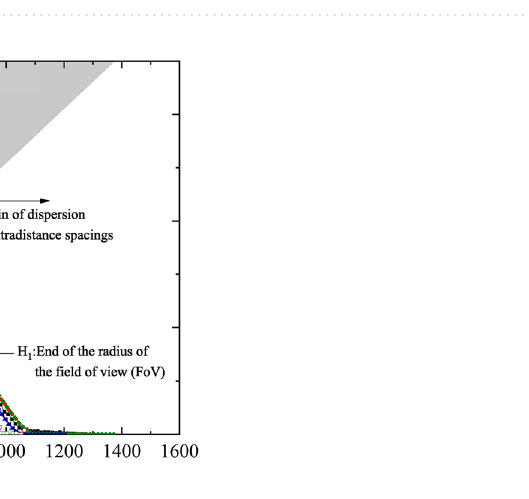
Figure 11. Plot of the radial distribution function H 1 ( r i ) and H 2 ( r i ) for samples a2, b2, c2, d2, e2, and f2 after being etched for 2 h.